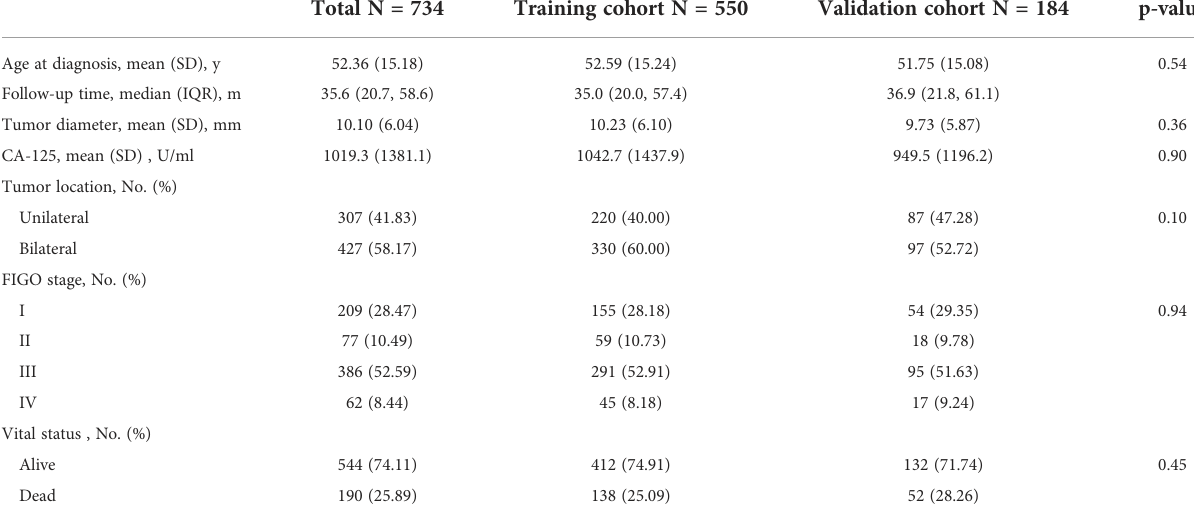
TABLE 1 Clinical characteristics of patients in training and validation